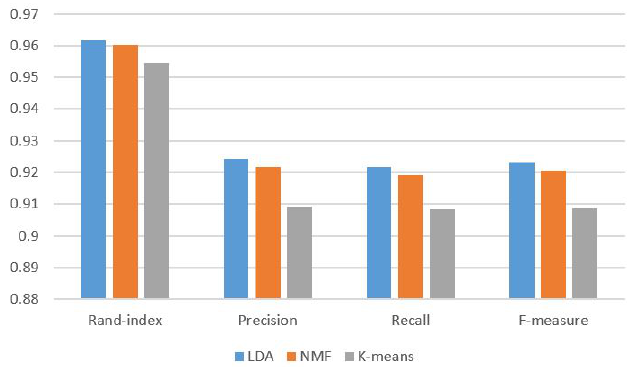
Figure 6. Accuracy of LDA, NMF and K-means for each class on dataset without overlapping.